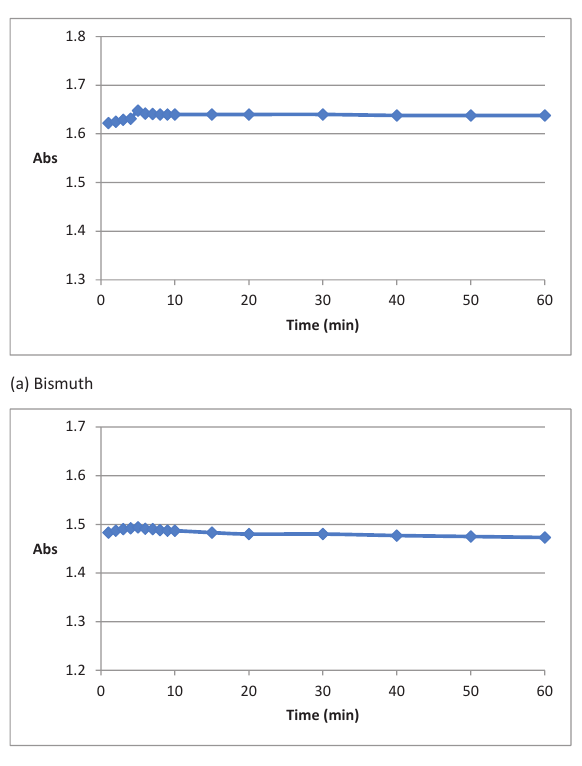
Figure 22: Stability of complexes with time.